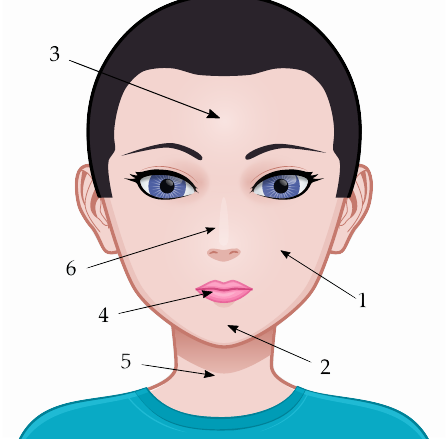
Figure 1. The six facial regions considered in the study: (1) cheeks, (2) chin, (3) forehead, (4) lips, (5) neck and (6)